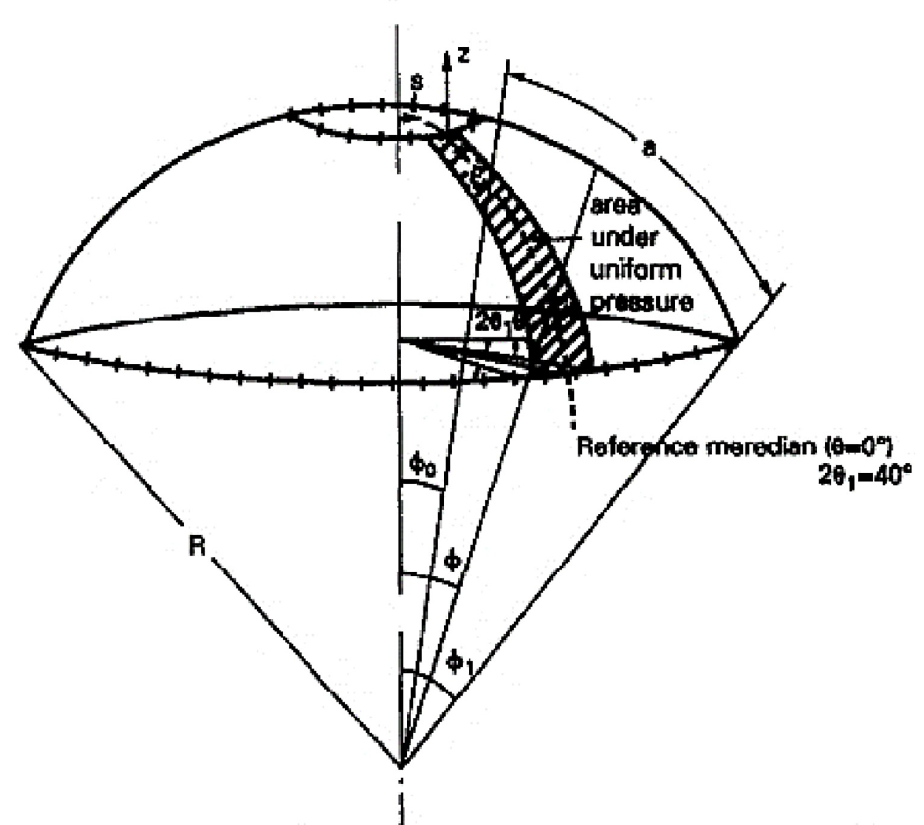
Fig 16. Spherical shell under asymmetric